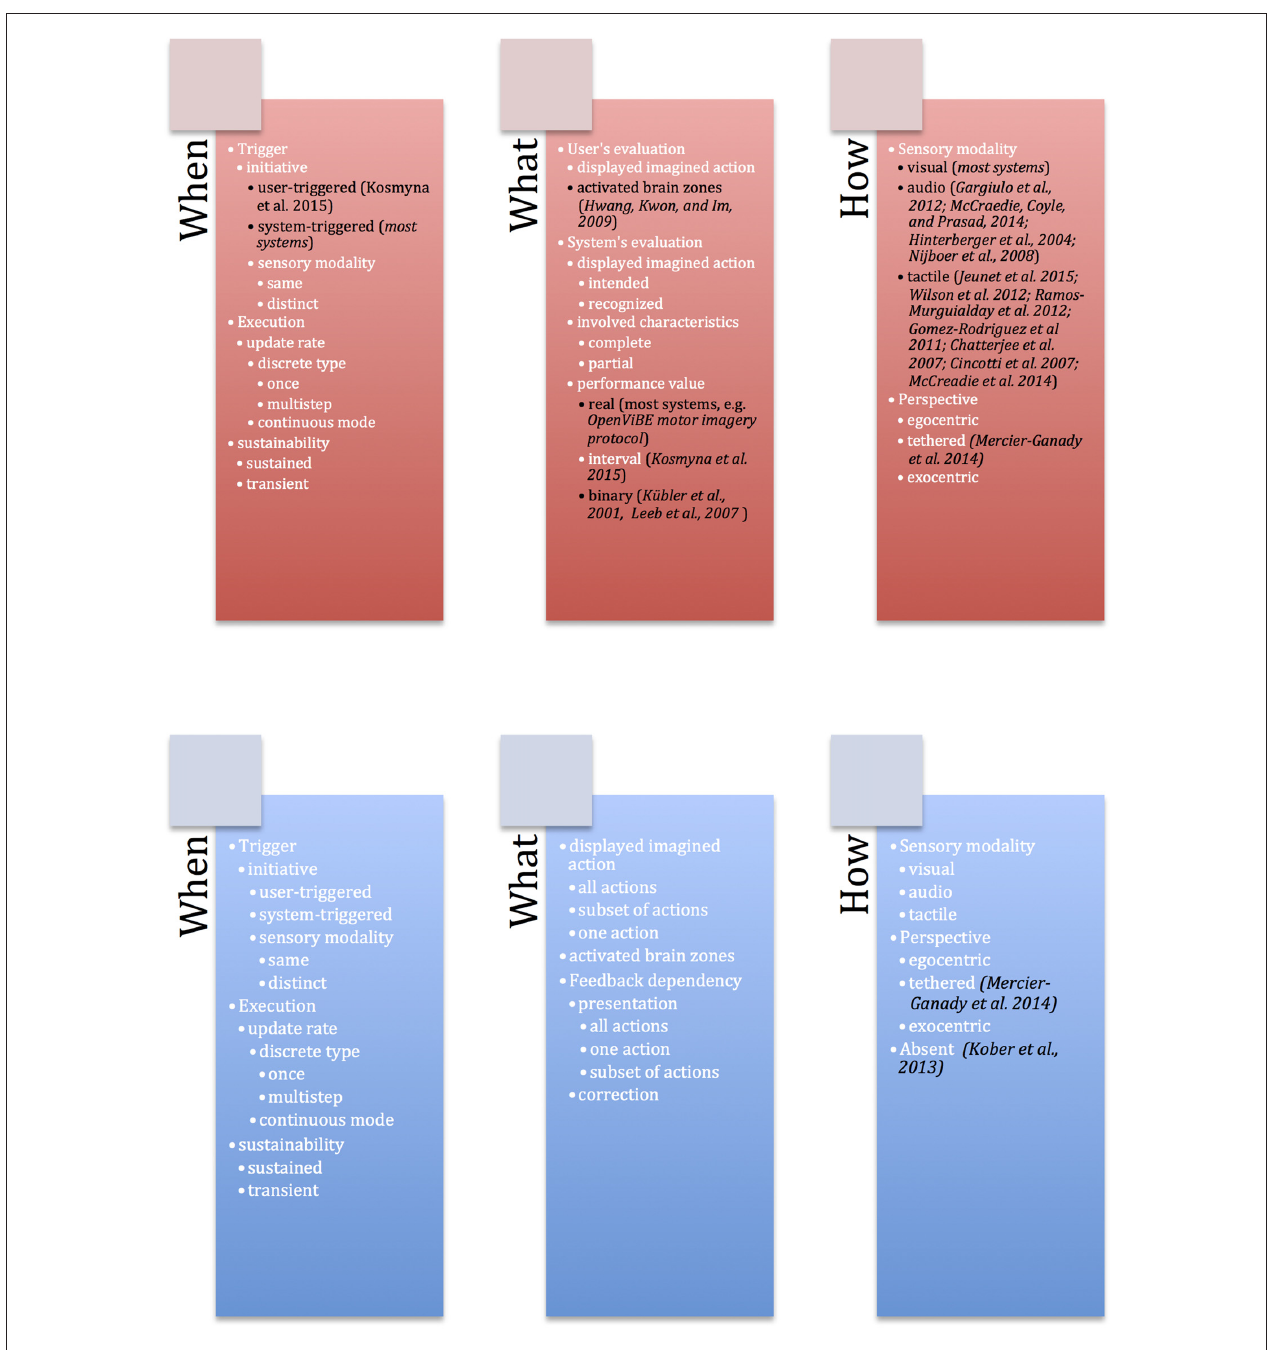
FIGURE 5 | Coverage of the proposed guiding system with examples of the existing works from state of the art represented in black.